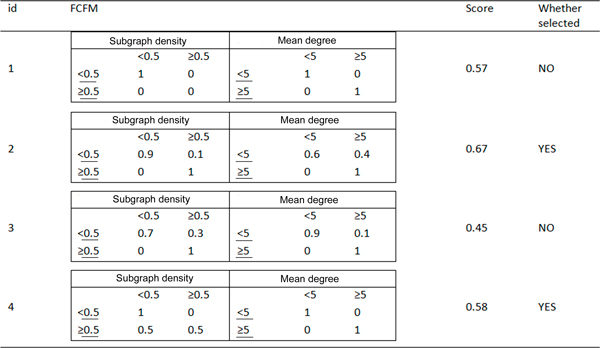
Population of FCFM in second iteration of Genetic algorithm. Member 1 has escaped mutation in the first iteration. Since members 2 and 5 have high scores they have been selected. 1 and 3 will be deleted and they will be replaced by progeny generated by crossover and mutation.